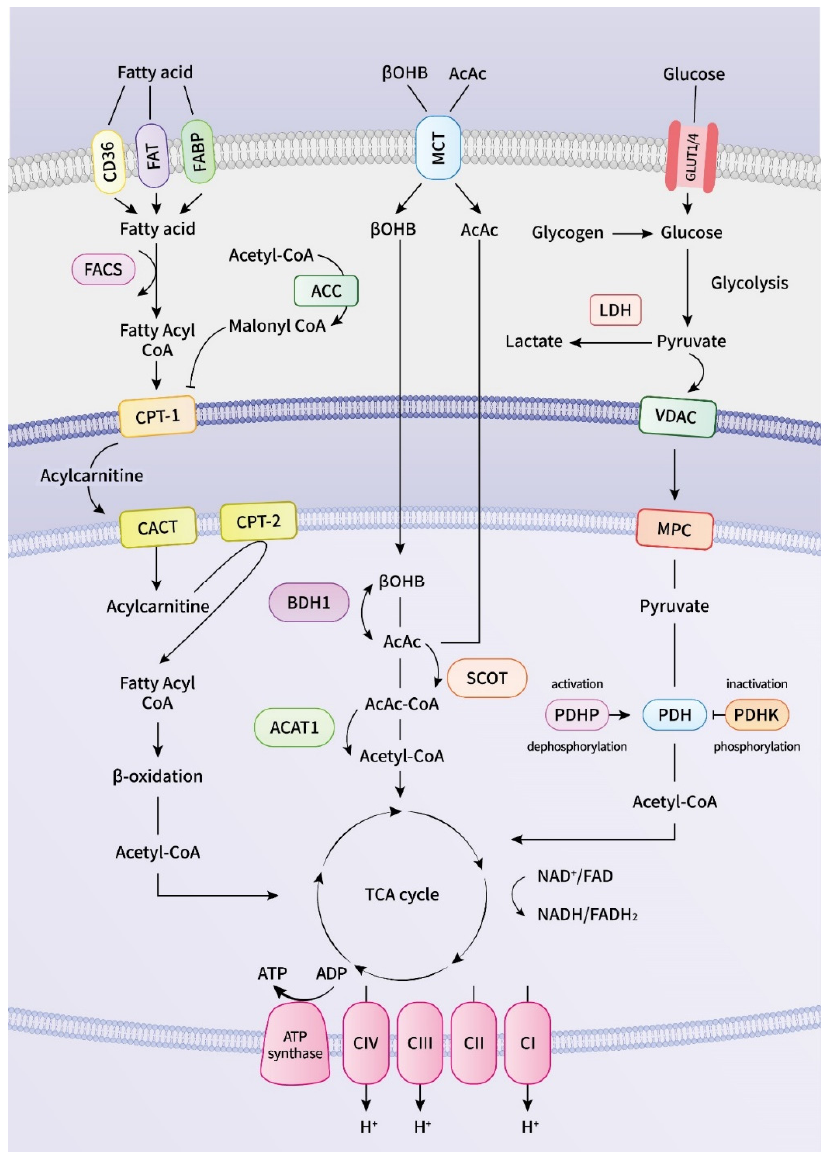
Figure 1. Schematic illustration of myocardial energy metabolism. In the mitochondria, acetyl- CoA generated from fatty acid, glucose, and ketone bodies oxidation enters the tricarboxylic acid (TCA) cycle to produce NADN and FADH 2 , which donate their electrons to the mitochondrial complexes of electron transport chain to generate a proton gradient required for OXPHOS and ATP synthesis. AcAc, acetoacetate; ACAT, acetoacetyl CoA thiolase; ACC, acetyl CoA carboxylase; BDH, β -hydroxybutyrate dehydrogenase; β OHB, β -hydroxybutyrate; CACT, carnitine–acylcarnitine translocase; CPT, carnitine palmitoyl transferase; FABP, fatty acid-binding protein; FACS, fatty- acyl-CoA synthetase; FADH, reduced flavin adenine dinucleotide; FAT, fatty acid transport; GLUT, glucose transporter; LDH, lactate dehydrogenase; MCT, monocarboxylic acid transporter; MPC, mitochondrial pyruvate carrier; NADH, reduced nicotinamide adenine dinucleotide; PDH, pyruvate dehydrogenase; PDHP, PDH phosphatase; PDHK, PDH kinase; SCOT, succinyl-CoA:3-ketoacid CoA transferase; VDAC, voltage-dependent anion channels.